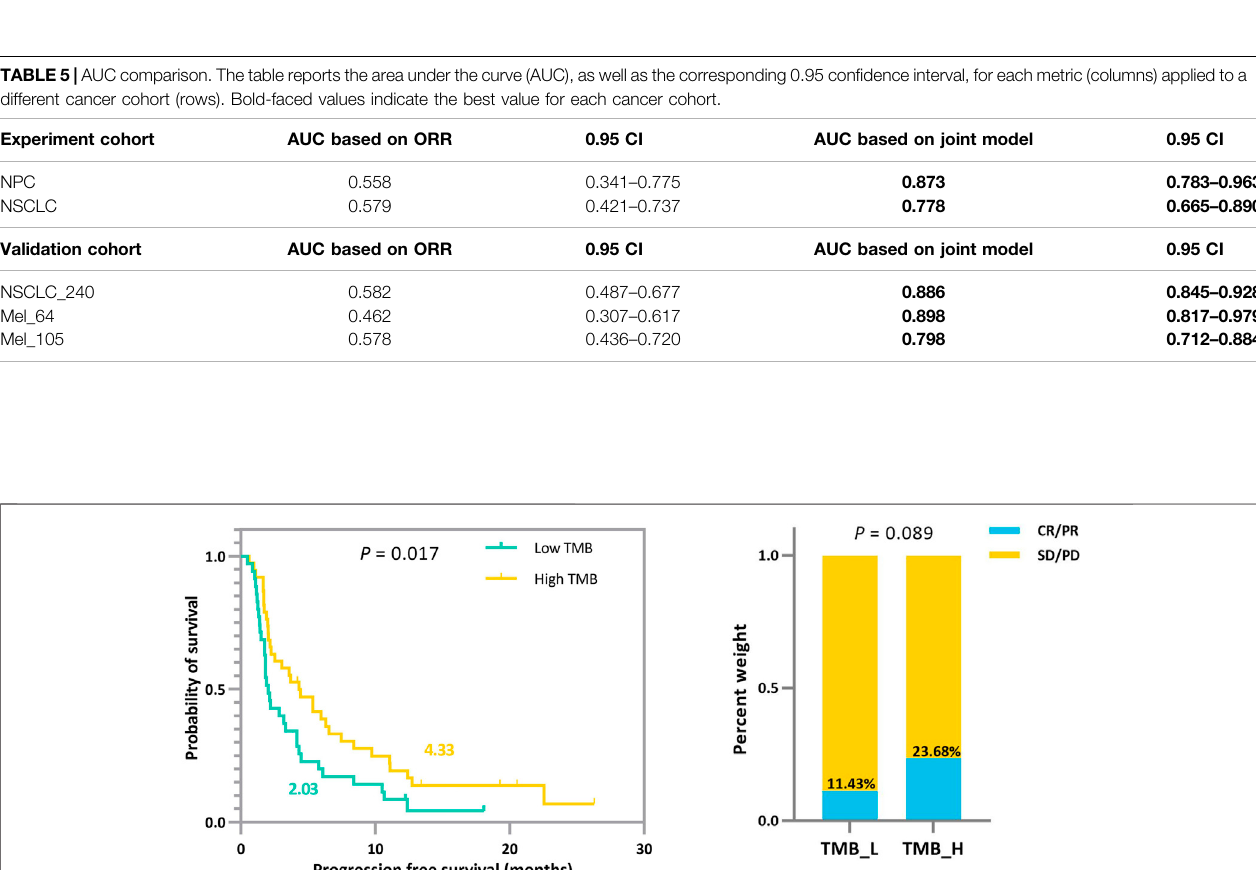
FIGURE 5 | Receiver operating characteristic curves of the predictive capacity of prognosis label for two experiment cohorts and validation cohorts, depicting the true-positive rate (sensitivity, y -axis) and false-positive rate (1-speci fi city, x -axis) for the metric across all possible TMB thresholds considering measurement errors. The corresponding area under the curve (AUC) is illustrated in the fi gure legends. (A) ROC curves for NPC (Panel), NSCLC (WES) experiment cohort, Mel_64 cohort, Mel_105cohort,andNSCLC_240cohortbasedonORRlabelsconsideringTMBmeasurementerrors. (B) ROCcurvesforNPC(panel),NSCLC(WES)experiment cohort, Mel_64 cohort, Mel_105 cohort, and NSCLC_240 cohort based on the mixed-endpoint labels considering TMB measurement errors.